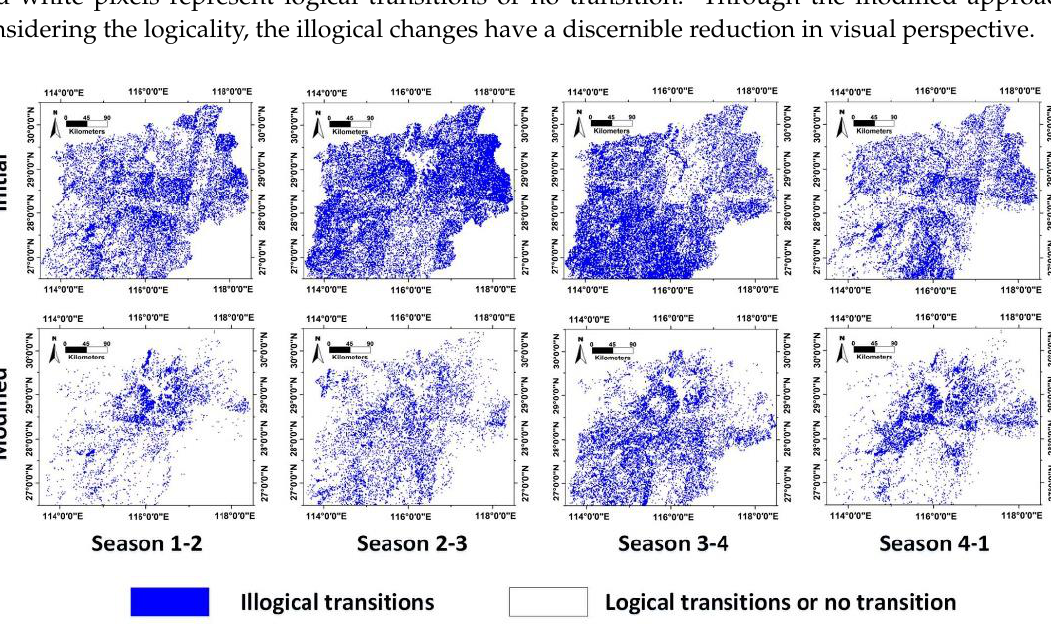
Figure 7. Illogical transitions before and after modification.